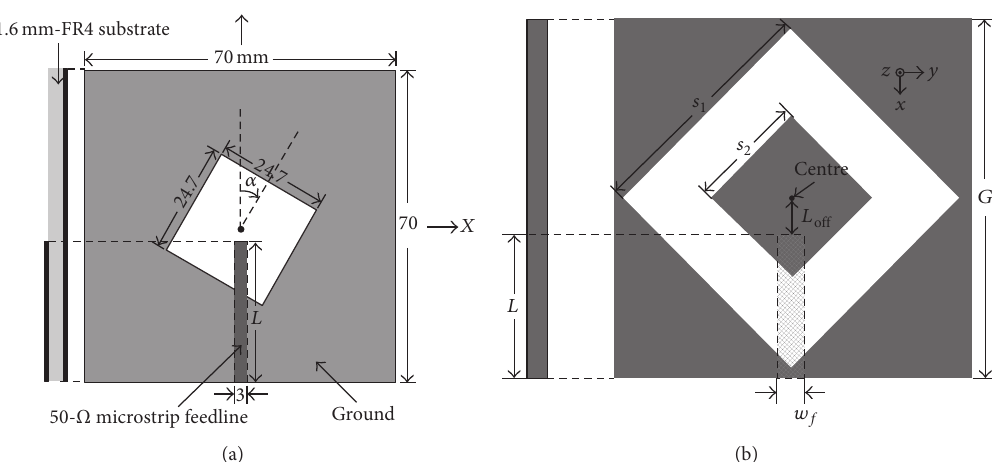
Figure 28: Geometry and dimensions of the microstrip line-fed printed square slot antenna with (a) rotated slot [84] and (b) rotated slot with parasitic centre patch